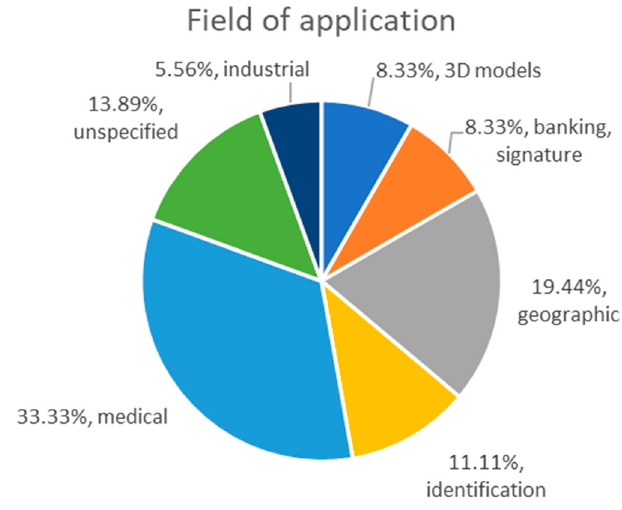
Figure 1. Repartition of fields of application in reviewed articles.